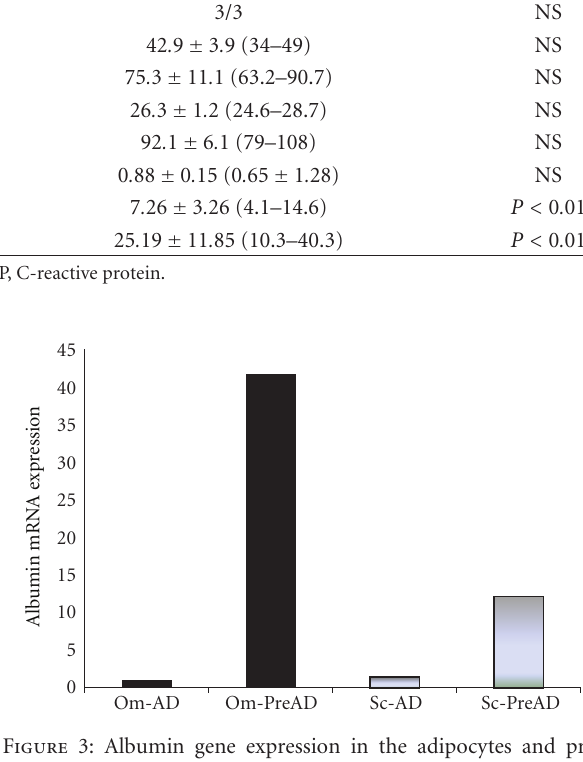
Figure 2: Albumin gene expression in the adipocytes from di ff erent sites of adipose tissue, obtained by real-time PCR analysis. The columns show the relative expression of albumin mRNA in subcutaneous (Sc, gray bars) and omental (Om, black bars) adipose tissue fragments of healthy noninflamed subjects (Sc-n and Om-n, resp.) compared with those obtained in both Sc and Om adipose tissue of inflamed patients (Sc-infl and Om-infl, resp.). The values on the y -axis represent arbitrary units derived from the mean expression value for albumin gene. Values are expressed in arbitrary units as means ± S.D. of 12 experiments. ∗ P < 0 . 05 compared with Sc-infl and Sc-n.